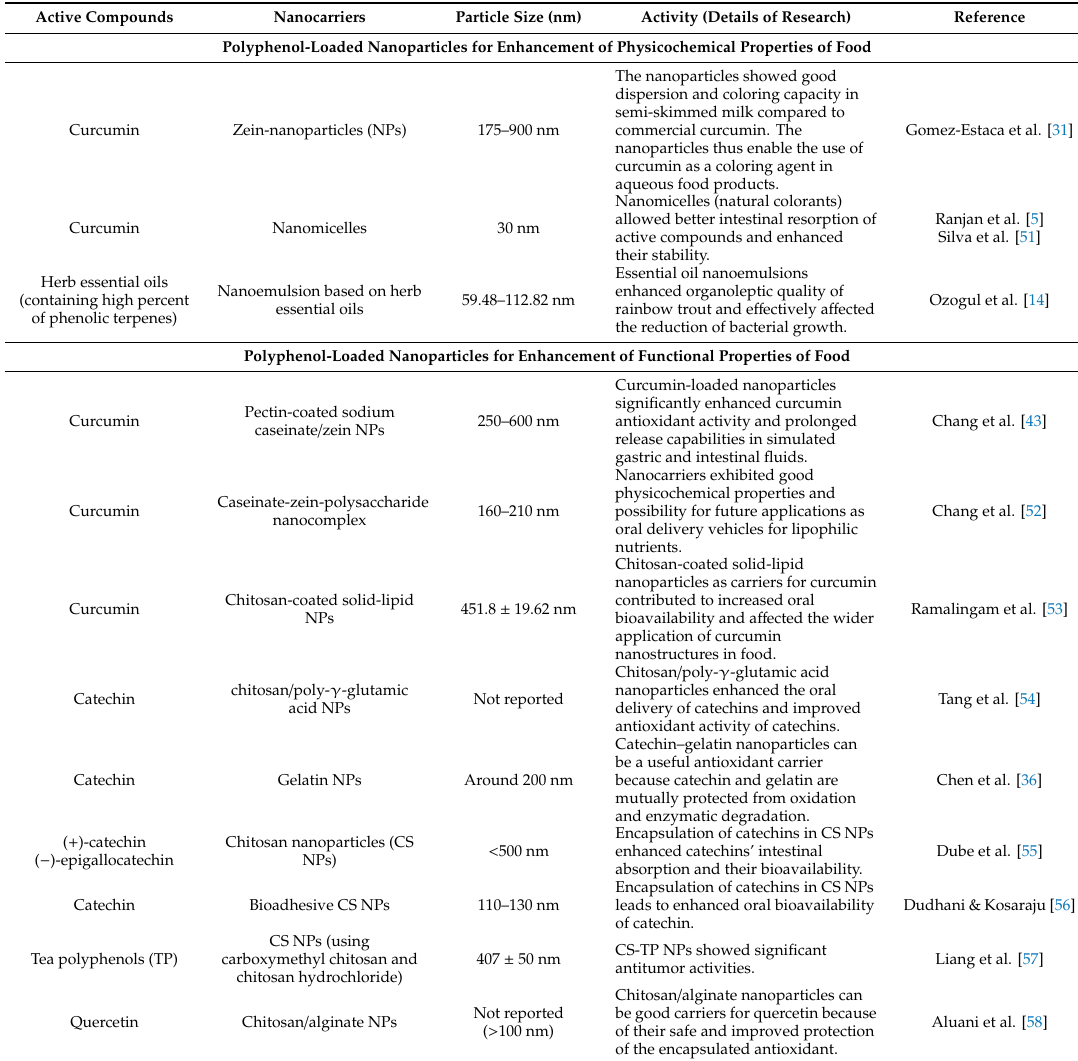
Table 1. Nanoencapsulation of phenolics important for food